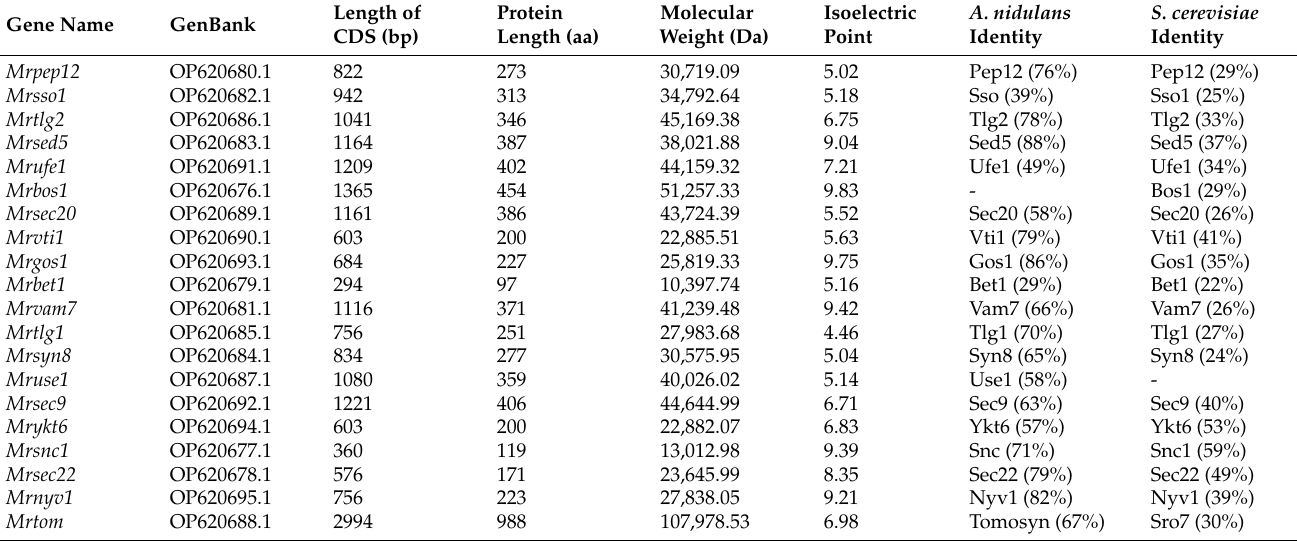
Table 1. Physicochemical parameters of identified MrSNAREs